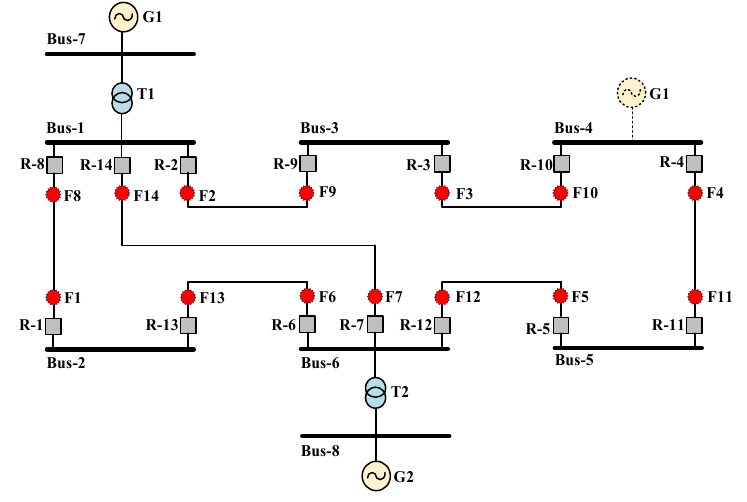
Figure 4. IEEE 8-Bus network. Table 3. Fault currents data and primary-backup relays.